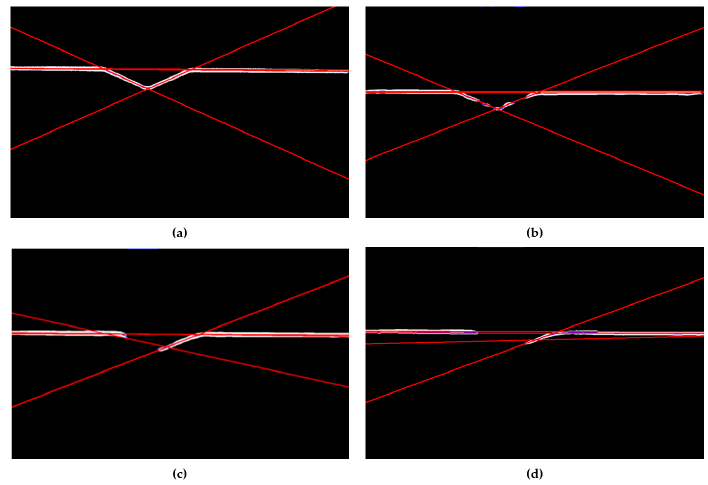
Figure 11. Comparison of the segmentation effects.